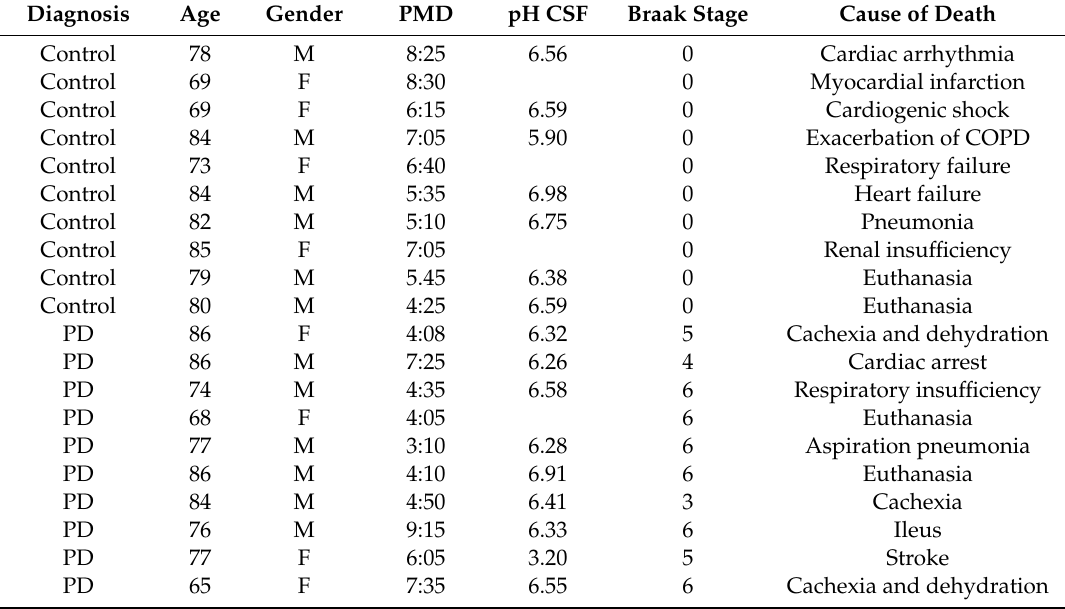
Table 1. Clinical information on the post-mortem human brain